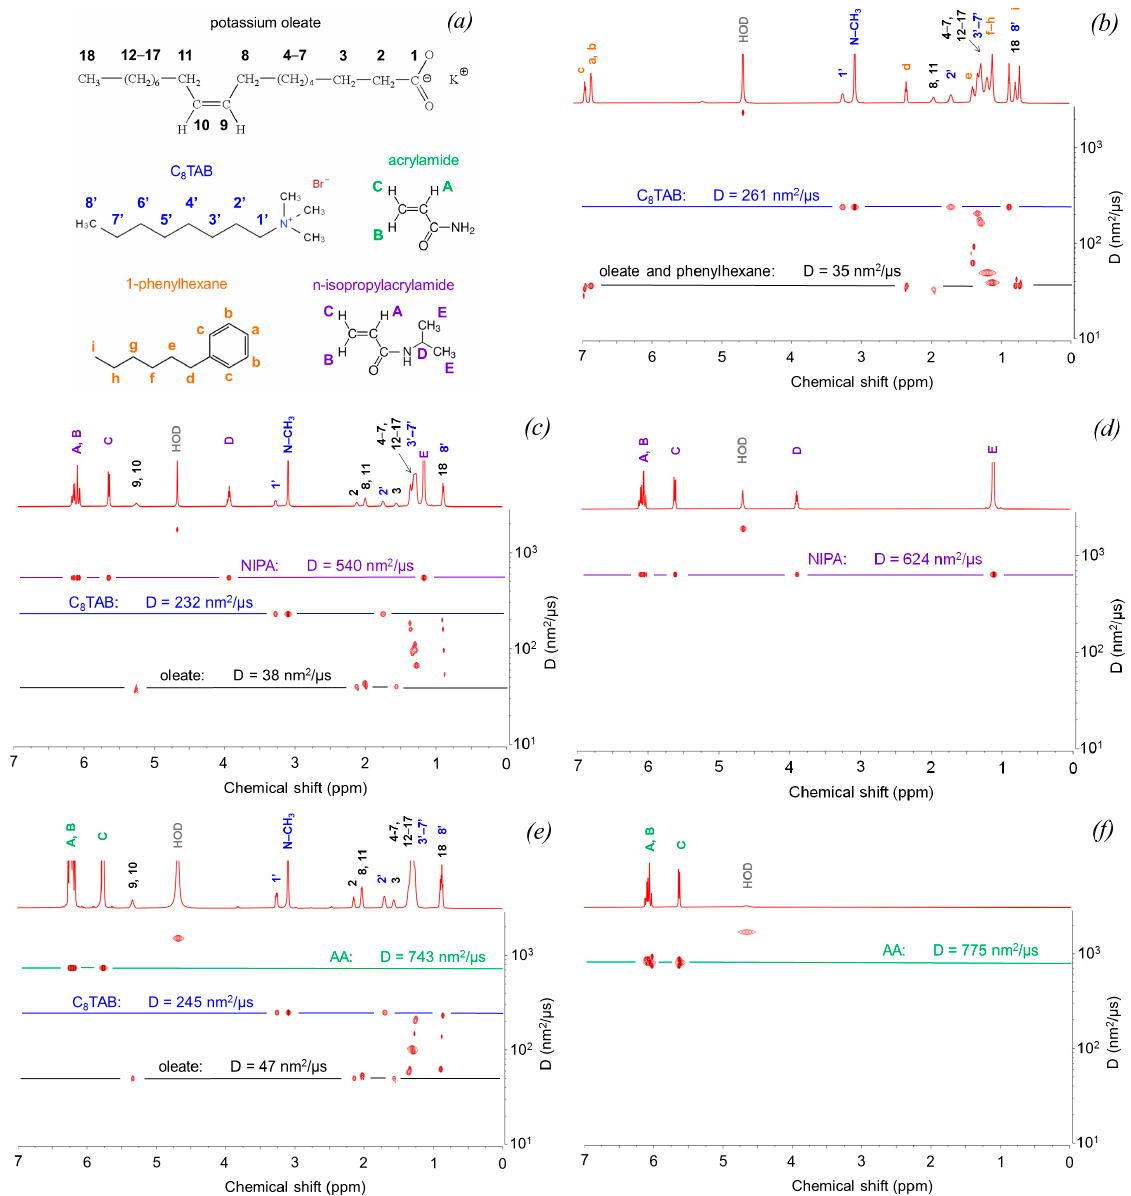
Figure 6. ( a ) Chemical structures of surfactants and additives. ( b – f ) Pseudo-2D DOSY spectra for different systems: ( b ) surfactants with 250 mM 1-phenylhexane; ( c ) surfactants with 620 mM NIPA; ( d ) 620 mM NIPA without surfactants; ( e ) surfactants with 20 wt% AA; ( f ) 20 wt% AA without surfactants. Concentrations of surfactants: 78 mM potassium oleate, 117 mM C8TAB. Solvent: KOH in D 2 O, pH 11.